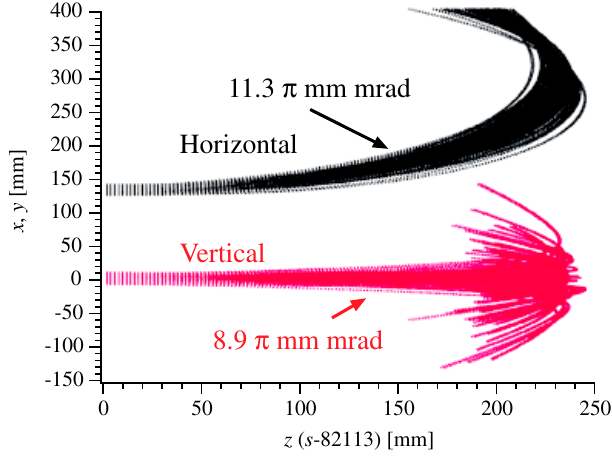
FIG. 13. (Color) B , B , B distribution in the shift-bump area at x y z (cid:2) x; y (cid:3) (cid:4) (cid:2) 131 ; 10 (cid:3) (cid:8) mm (cid:9) . The stripping foil is placed at z (cid:4) 0 ( s (cid:4) 82 : 113 m ).